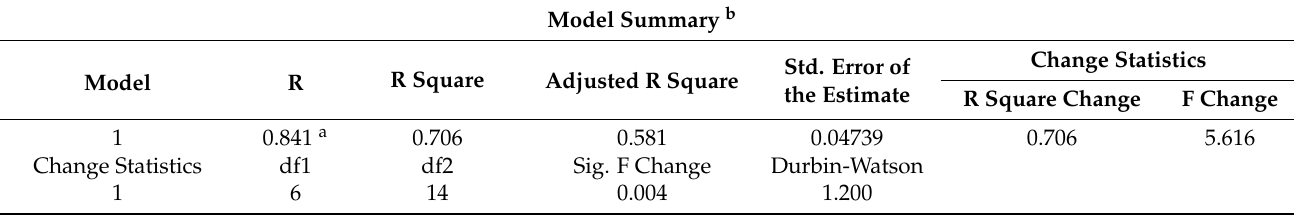
Table 7. The model of analysis for